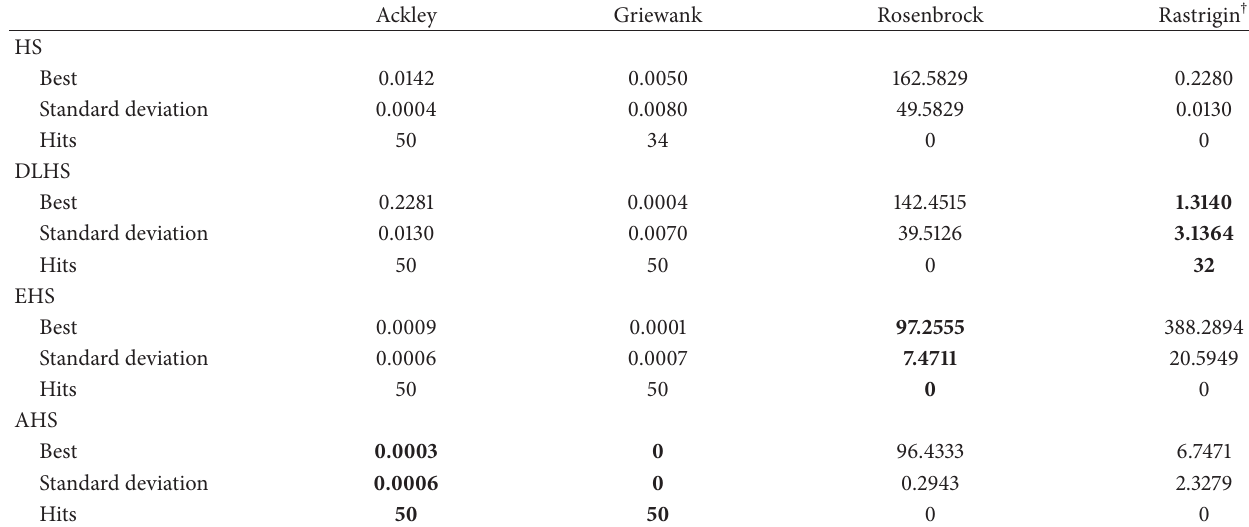
Table 3: Average scores and standard deviations over 50 runs for 100-dimensional problems. The optimisers were allowed to run for 500,000 function